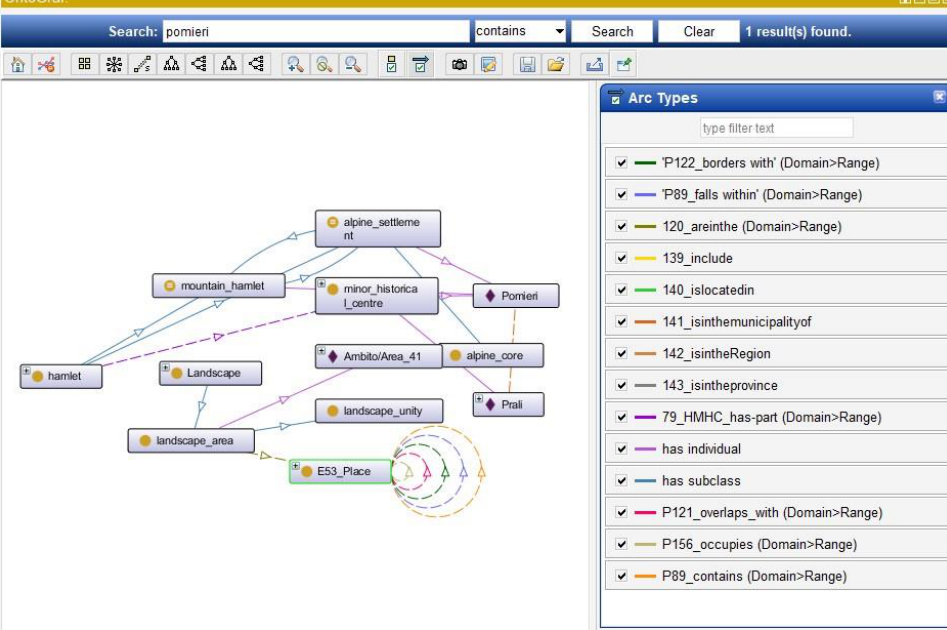
Figure 16. OntoGraf visualisation of classes and instances of the MHC ontology related to the Pomieri hamlet case